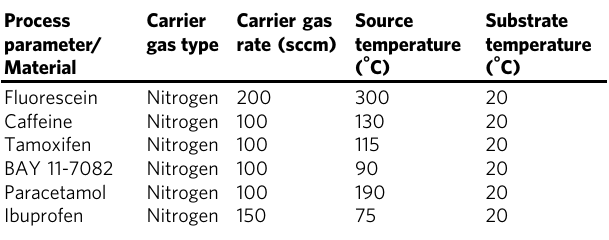
Table 1 OVJP processing conditions for materials used in the study. Source temperature was determined via thermogravimetry and tuned to obtain a local deposition rate of ~0.5 μ g per min Process parameter/